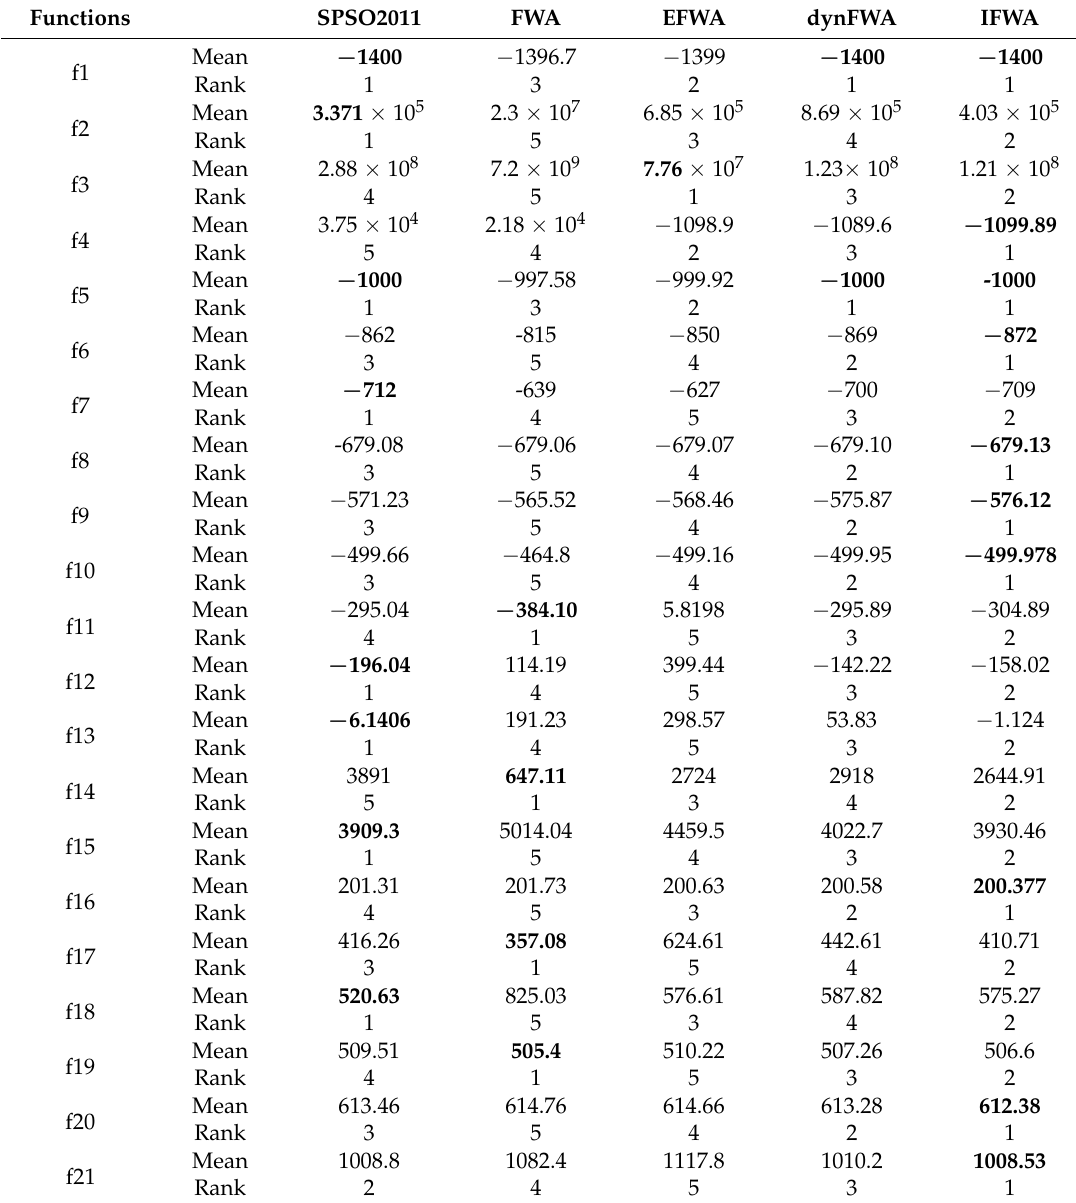
Table 3. Average fitness value and total number of rank